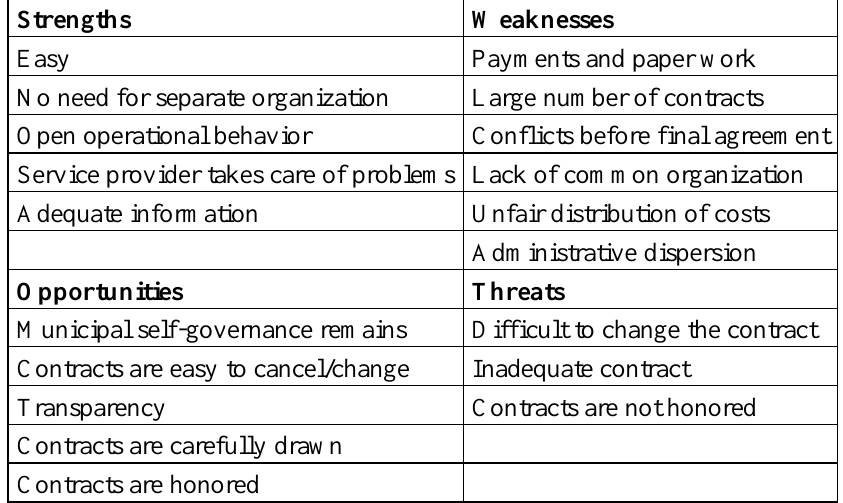
Table 2. SWOT analysis of the functioning of bilateral collaboration